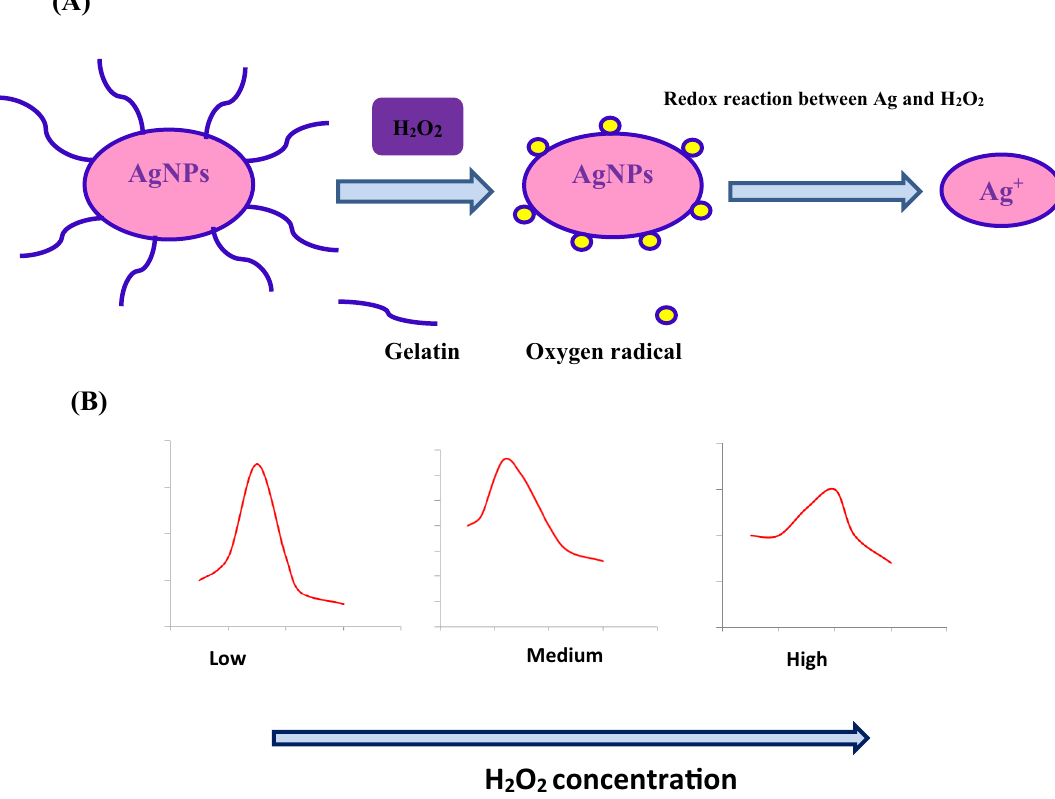
Figure 12. A schematic model of the probable mechanism of a catalytic reaction between OG-AgNPs and H 2 O 2 ( A ) and a decrease in the absorbance intensity with increasing in H 2 O 2 concentration ( B